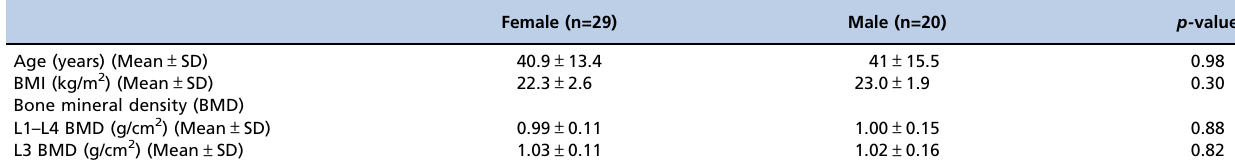
Figure 1 - A 31-year-old female volunteer. Illustrated are the segmentation and positioning of the volume of interest (VOI) in the L3 vertebral body using the IBEX program for volumetric (three-dimensional) extraction of textural attributes (TAs). Table 1 - Demographics, clinical characteristics, and bone mineral density of the study